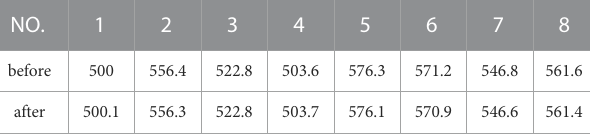
TABLE 7 Changes in weight of C2 specimens before and after capillary water absorption